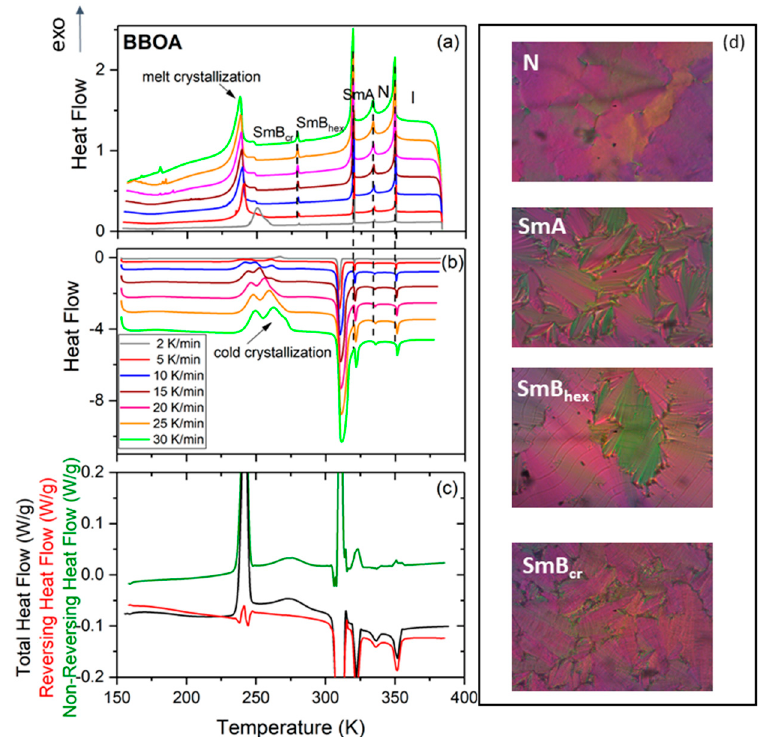
Figure 1. Differential scanning calorimetry (DSC) thermograms of 4-n-butyloxybenzylidene- 4 ′ -n ′ -octylaniline (BBOA) obtained at various rates of cooling ( a ) and heating ( b ). ( c ) MDSC thermogram of BBOA obtained for a heating rate 3 K min − 1 with a modulation amplitude of 0.5 K for a period of 60 s. ( d ) Exemplary textures of BBOA in various mesophases as indicated.